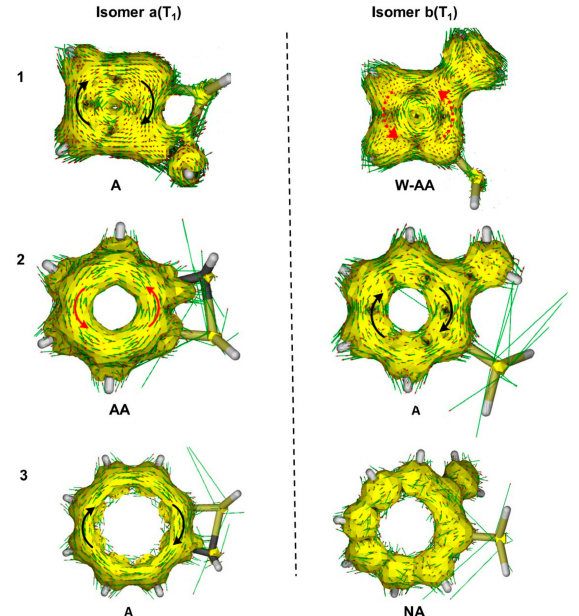
Figure 7. Anisotropy of the induced current density (ACID) plots at (U)B3LYP/6-311+G(d,p)// (U)B3LYP/6-311G(d,p) level. Broken arrows in 1b ( T 1 ) indicate weaker ring-currents. Aromatic = A, antiaromatic = AA, weakly antiaromatic = WAA, and non-aromatic = NA.